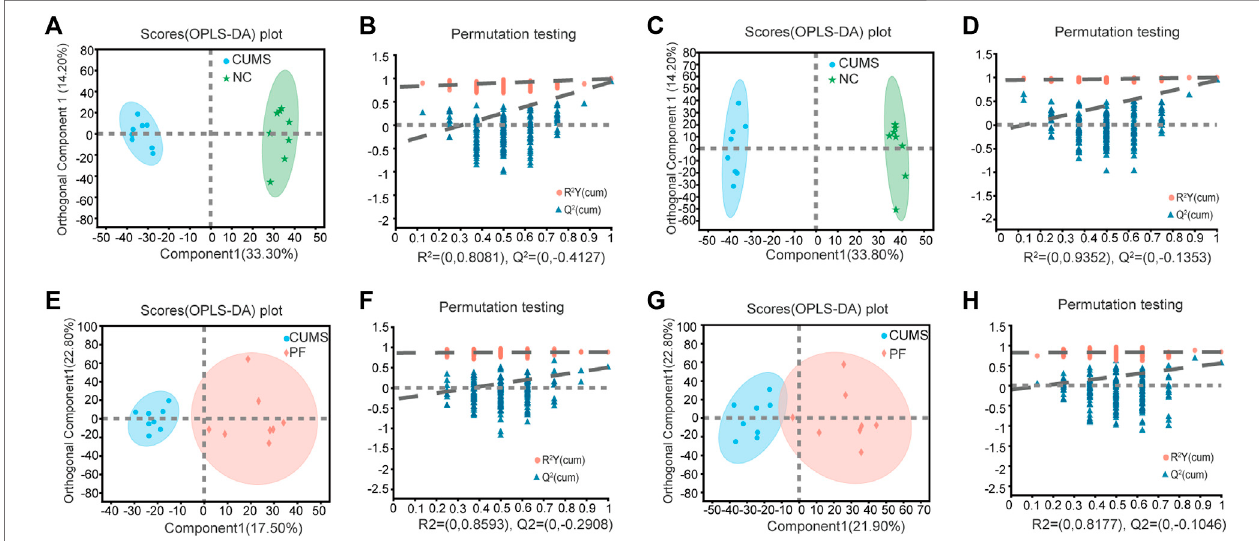
FIGURE 3 | Multivariate data analysis of urine metabolites of rat samples. OPLS-DA score plot and permutation test of the NC and CUMS groups (A,B) in the positiveionmode and (C,D) inthe negative ionmode. OPLS-DAscore plotand permutation test oftheCUMS and PFgroups (E,F) in thepositiveion modeand (G,H) in the negative ion